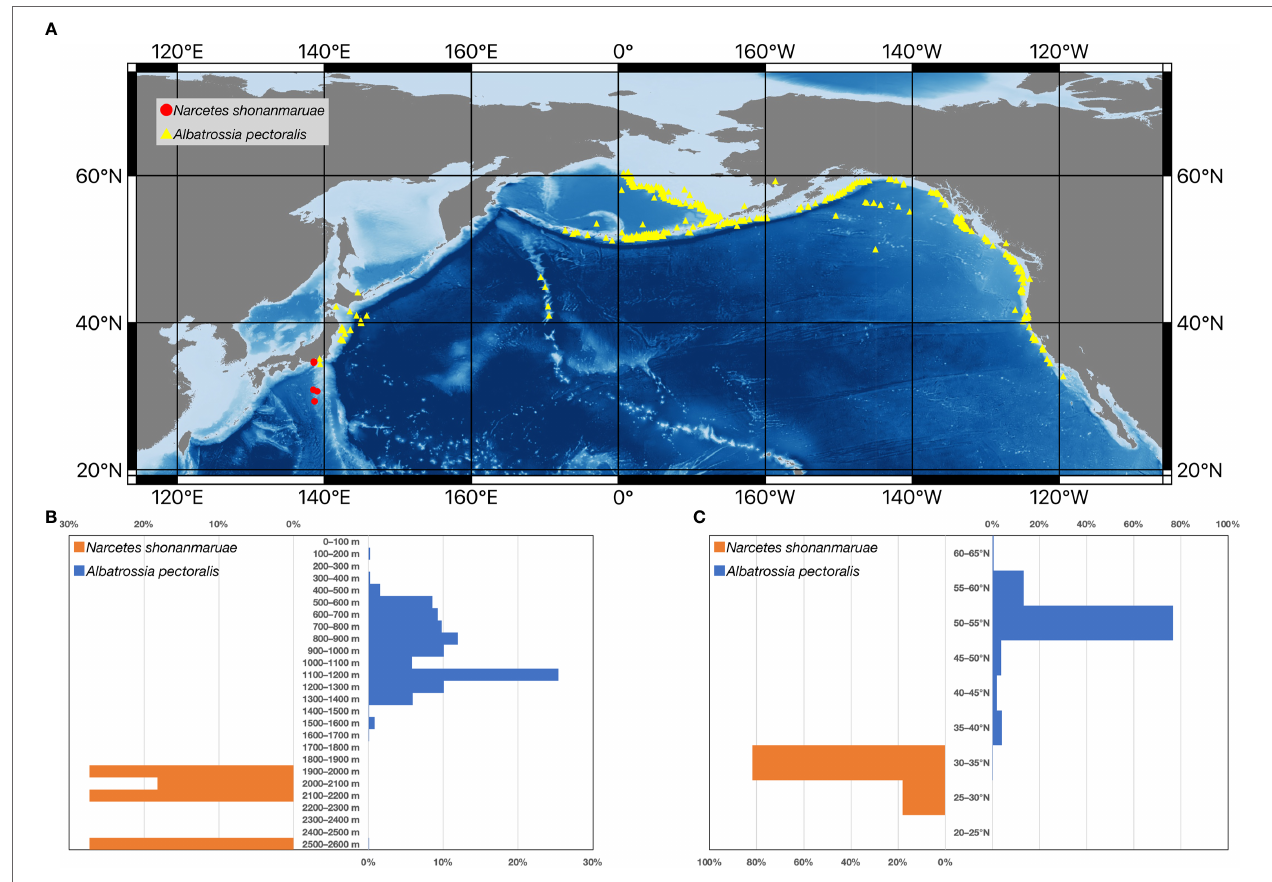
FIGURE 4 | Distribution patterns of the Yokozuna Slickhead Narcetes shonanmaruae and the Giant Grenadier Albatrossia pectoralis . (A) Geographic distribution of the Yokozuna Slickhead and the Giant Grenadier. (B) Depth distribution of the Yokozuna Slickhead and the Giant Grenadier. (C) Latitudinal distribution of the Yokozuna Slickhead and the Giant Grenadier. The distribution information of the Giant Grenadier is derived from the Ocean Biodiversity Information System (OBIS) ( OBIS, 2022